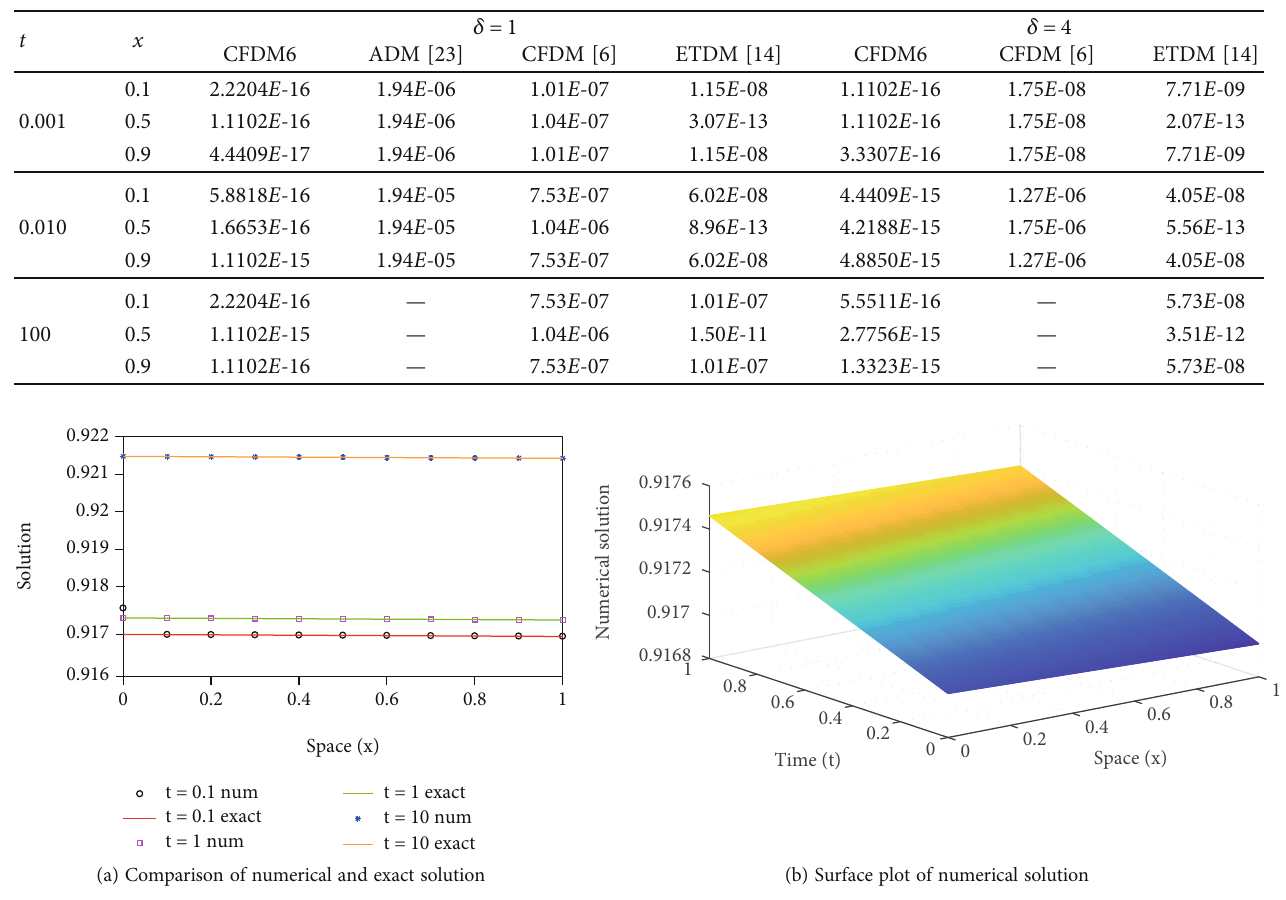
Figure 3: Graphical representation of solutions corresponding to Example 1 with N = 10 and Δ t = 0 : 001